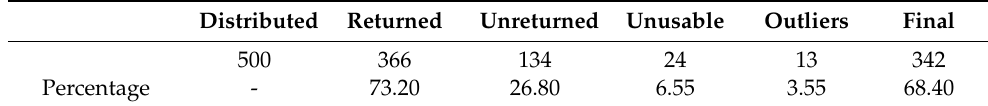
Table 1. Data cleaning, outliers, and response rate. Distributed Returned